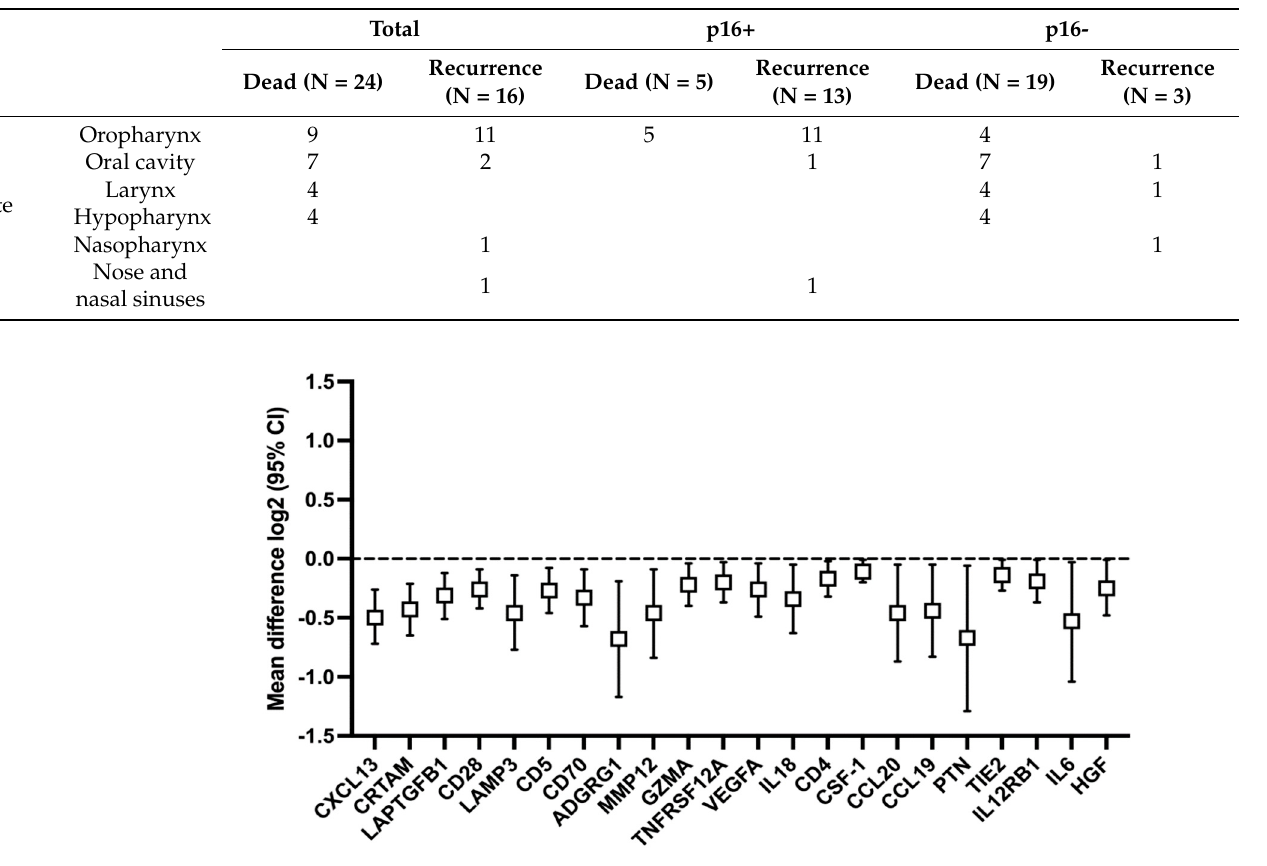
Figure 4. Forest plot on the effect of the p16 status on protein expressions at 12 months after the primary treatment in patients without failure within two years of the primary treatment. Only proteins with significant differences are shown, with increasing p -values from left to right (CXCL13 p = 0.000, HGF p = 0.042). Bars represent the confidence interval (CI), and the box represents the median.